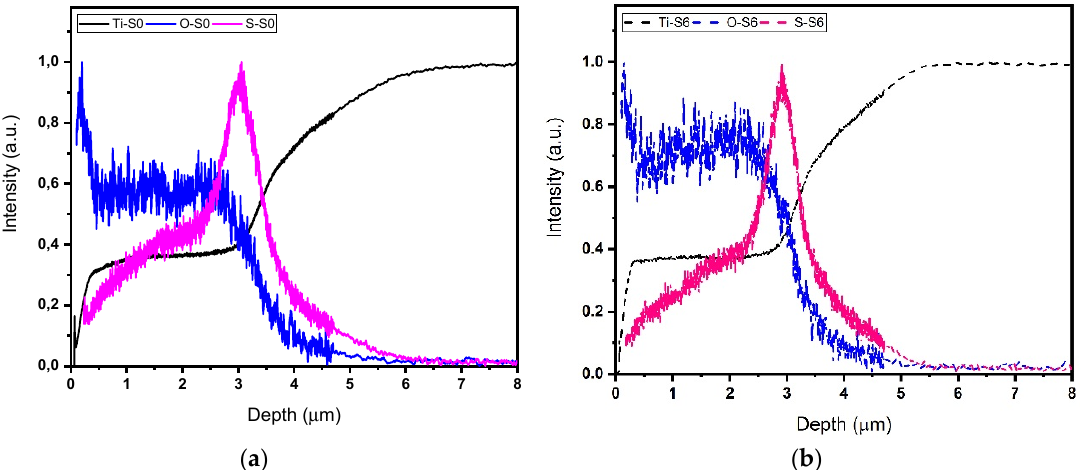
Figure 2. Glow discharge optical emission spectrometry (GD-OES) in-depth analysis for sample ( a ) S0 and ( b ) S6.